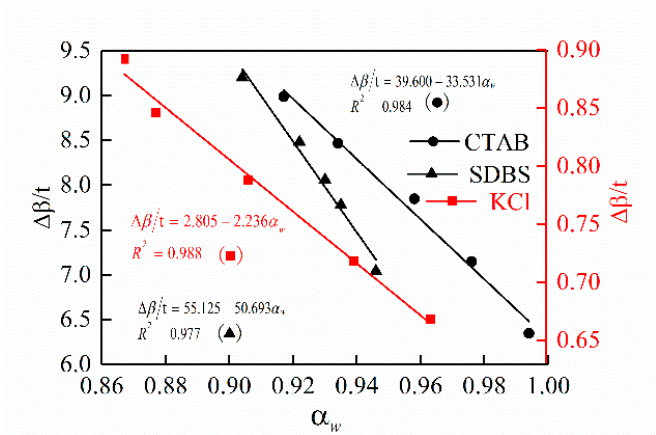
Figure 6. Relationship between drilling fluid activity and the rate of change of fluid–shale contact angle.